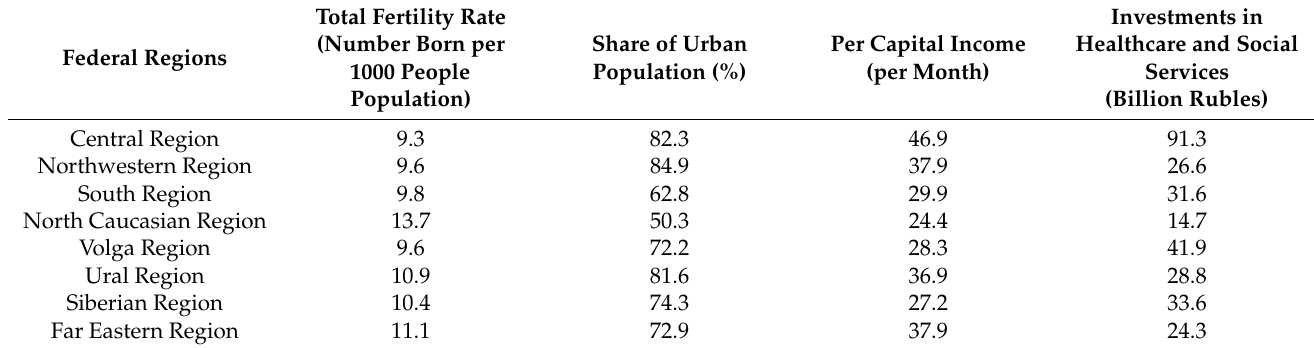
Table 1. Analyzed socio-economic indicators for the Russian regions for